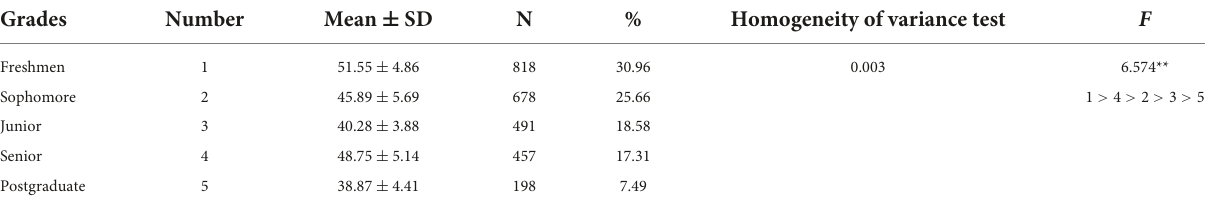
TABLE 6 Comparison of GSI T-score among different grades.